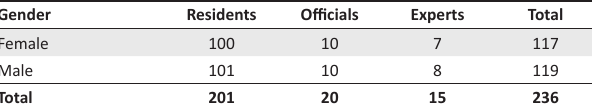
TABLE 2: Participants’ gender. Gender